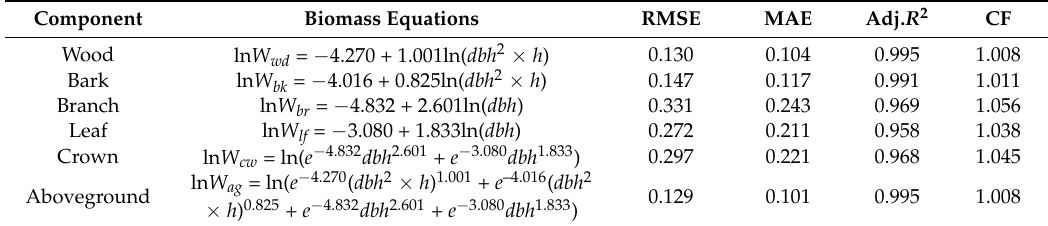
Table 5. Selected biomass equations simultaneously fitted through SUR methodology. CF is the correction